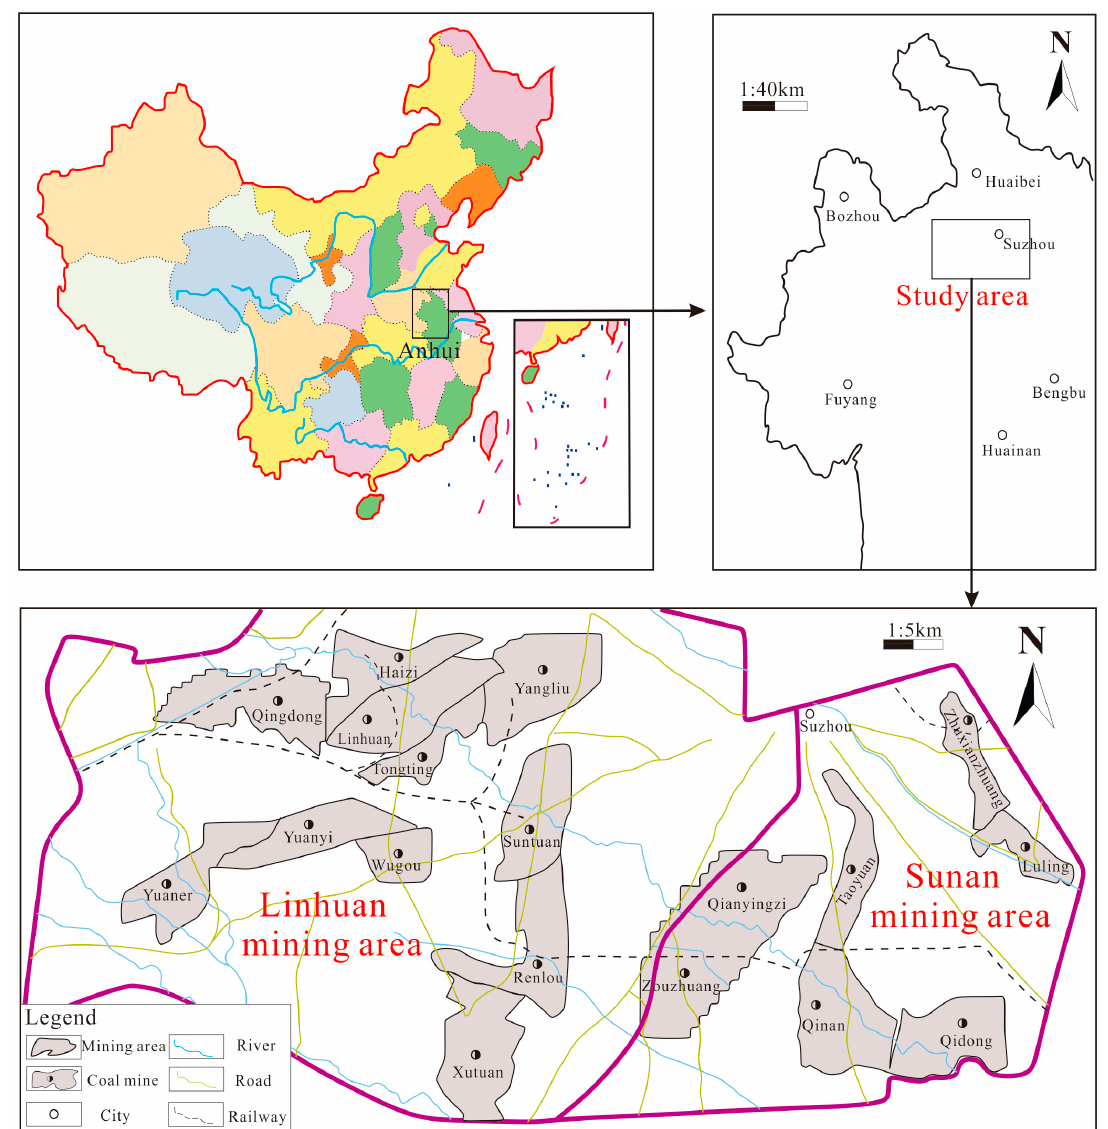
Figure 1. Geographical location of the Sulin mining area.